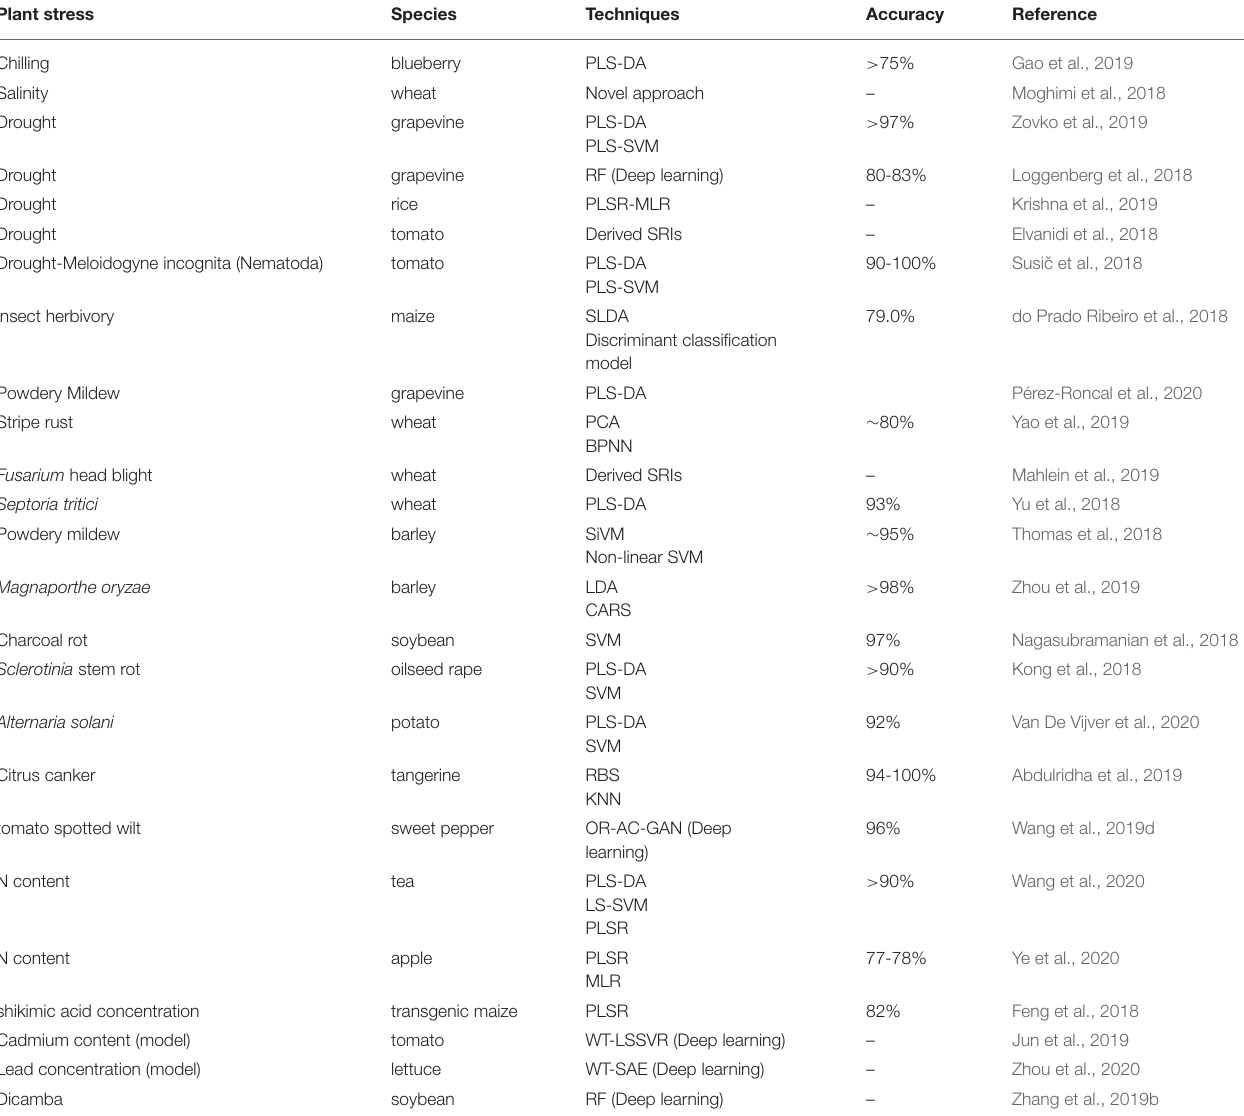
TABLE 2 | Published claims of stress identification from hyperspectral imaging since 2018, along with the chosen multivariate data processing technique and accuracy reached. “Plant stress” refers to both (i) the classification or modeling of stressful conditions and (ii) the plant phenotyping. Plant